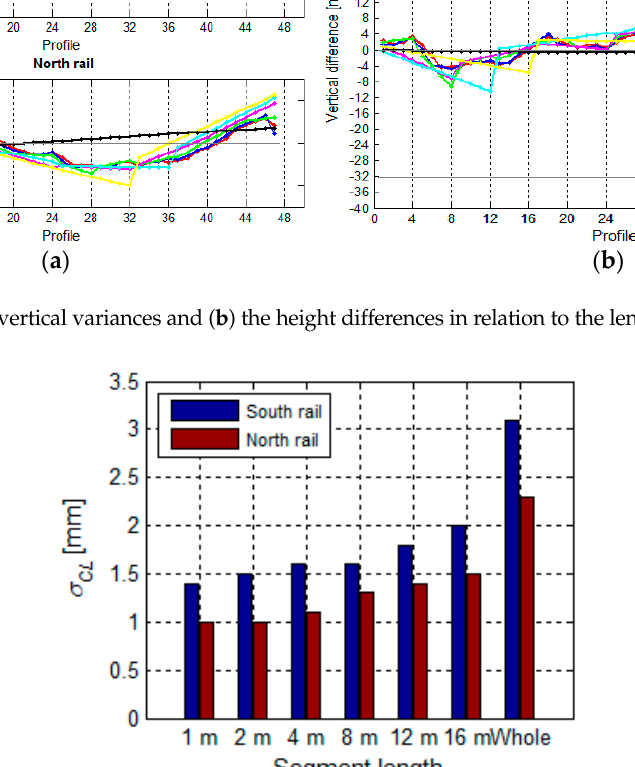
Figure 20. Precision of the characteristic lines in relation to the length of the segment.